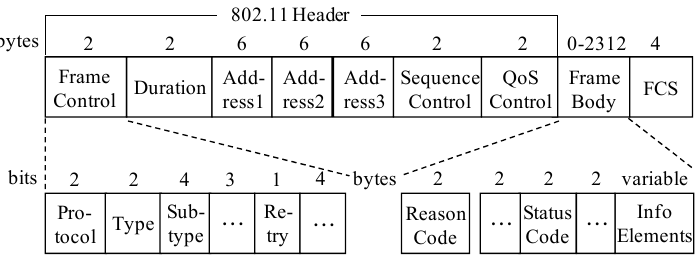
Figure 5. Generic 802.11 frame format. Table 2. Information fields description.